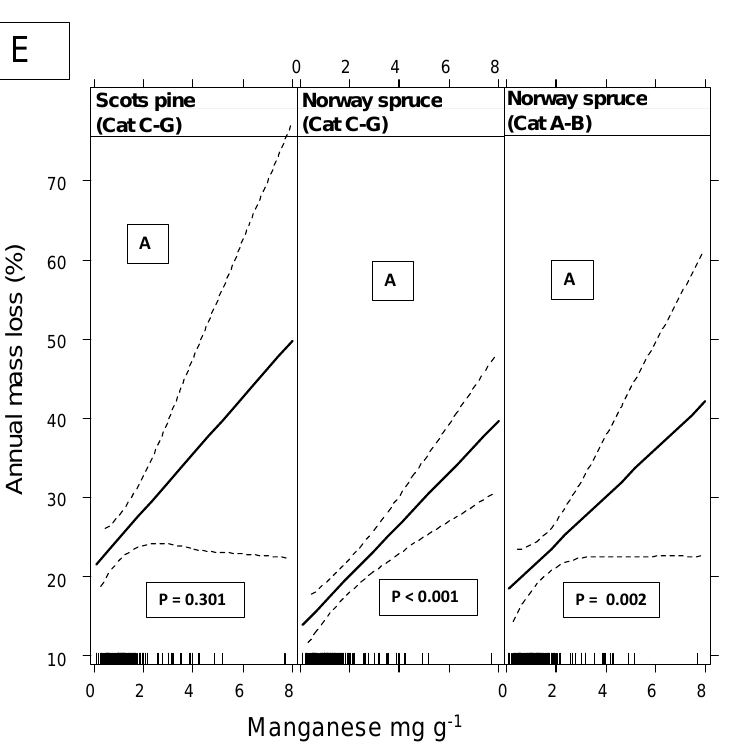
Figure 2. Annual mass-loss for Scots pine (categories C thru G; n = 74), and Norway spruce (cat- egories C thru G; n = 52) as well as Norway spruce litter (categories A and B; n = 36) related to ( A ) mean annual temperature (MAT), ( B ) mean annual precipitation (MAP), ( C ) concentration of AUR, ( D ) concentration of N, ( E ) concentration of Mn. The significance for single regression lines is given in each subfigure. Different upper-case letters indicate significant differences among the regressions. Figure is modified from [31].